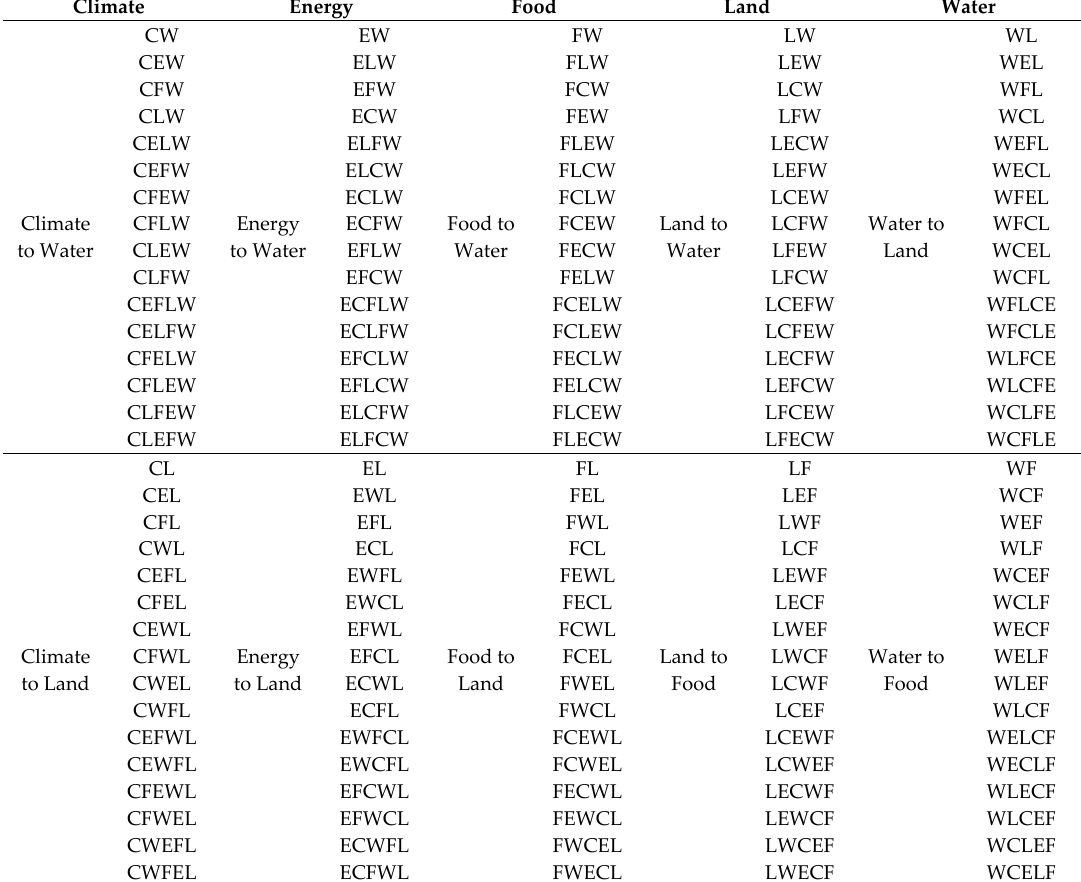
Table A1. List of 1st, 2nd, 3rd, and 4th degree pathways for all different Nexus